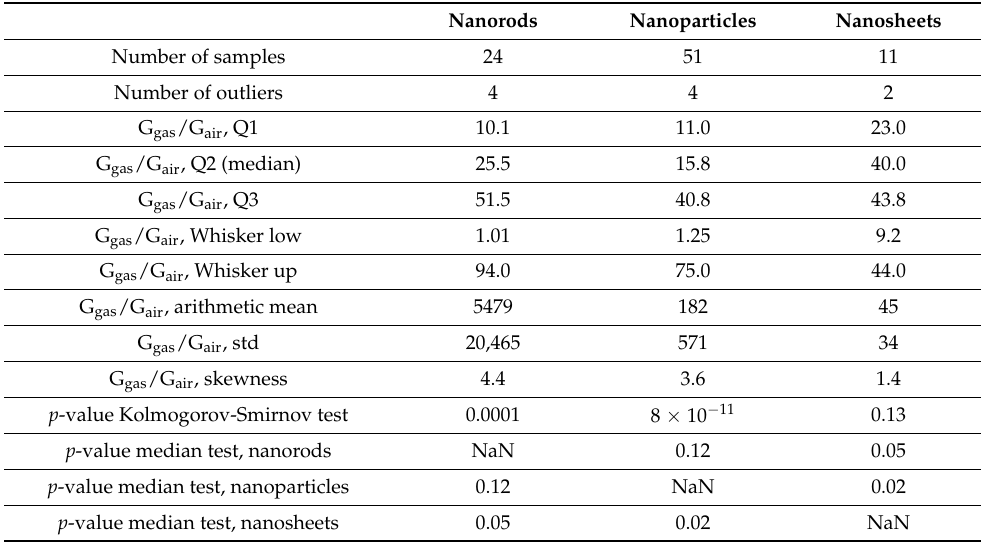
Table A1. Statistical analysis of responses G gas /G air to 100 ppm of ethanol grouped by crystallite morphologies, shown in Figure 6a.